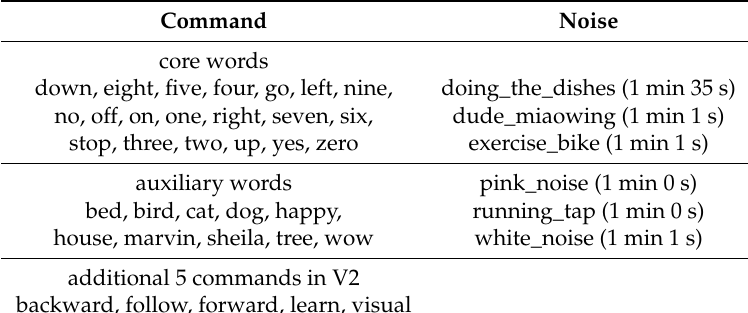
Table 2. Dataset